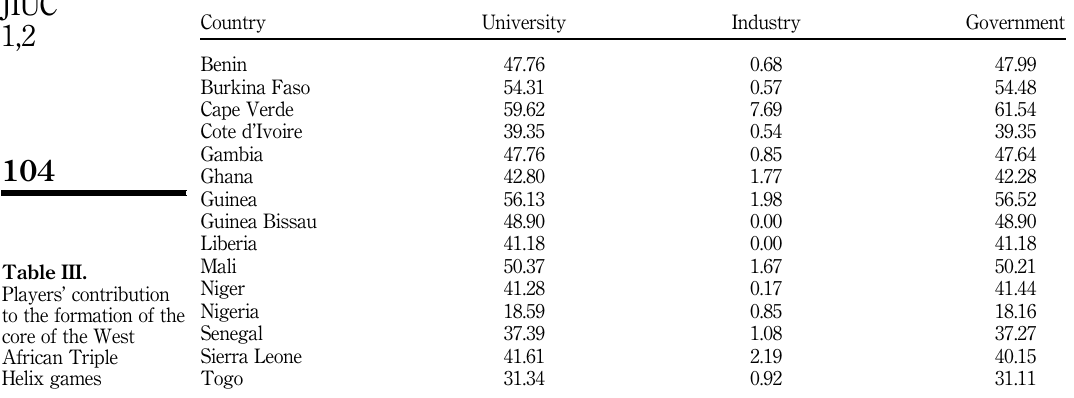
Table III. Players ’ contribution to the formation of the core of the West African Triple Helix